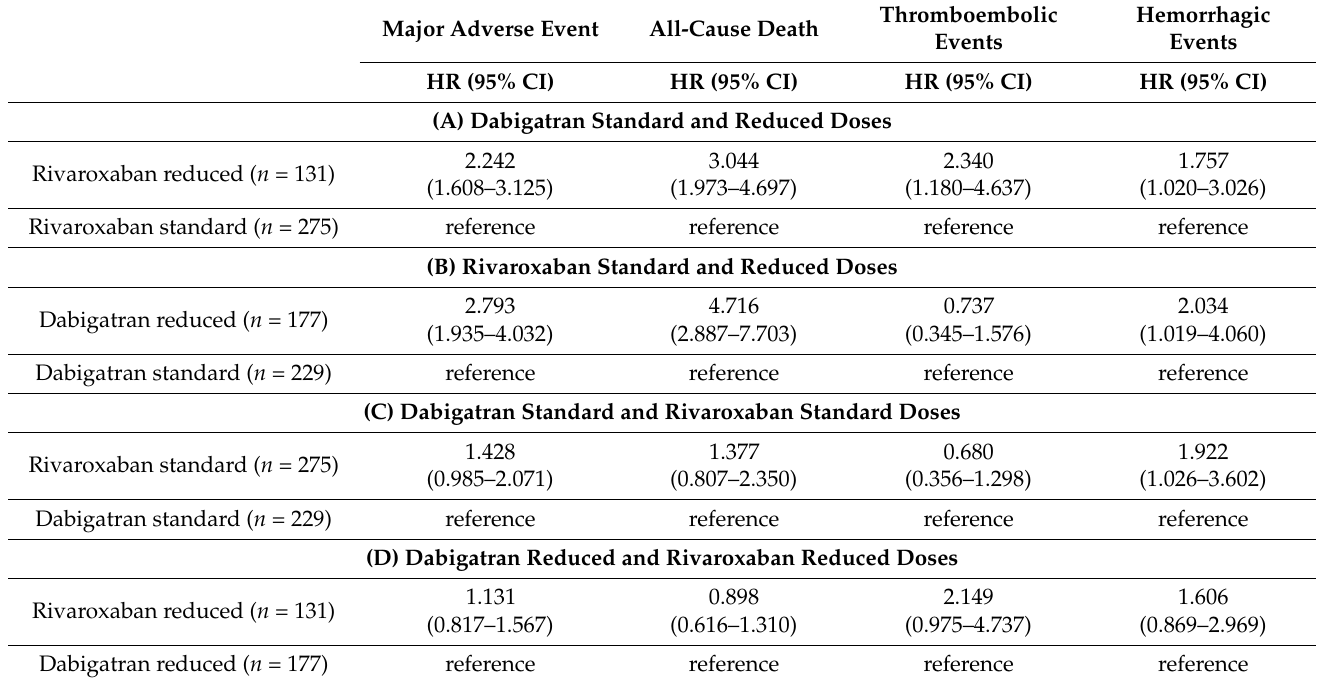
Table 3. Analysis of time-to- thromboembolic and hemorrhagic events for patients hospitalized in rivaroxaban standard and reduced doses ( A ) dabigatran standard and reduced doses ( B ) dabigatran standard and rivaroxaban standard doses ( C ) dabigatran reduced and rivaroxaban reduced doses ( D ) treatment group after propensity score matching (n = 406). Thromboembolic Major Adverse Event All-Cause Death Events